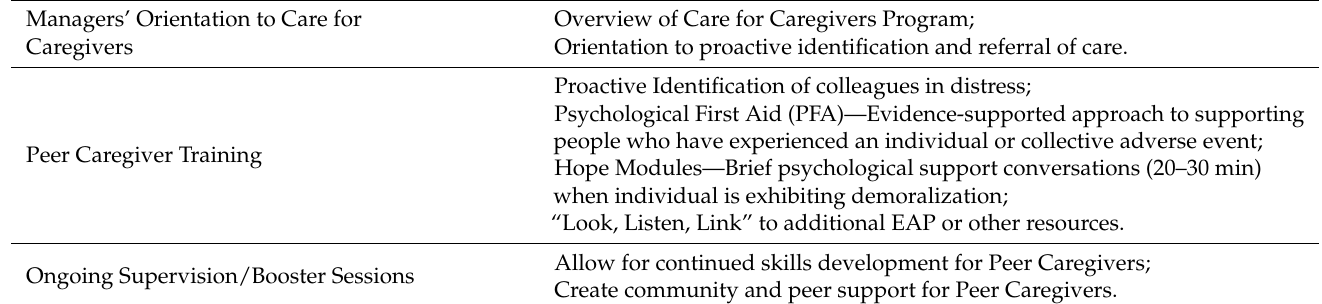
Table 1. Care for Caregivers training